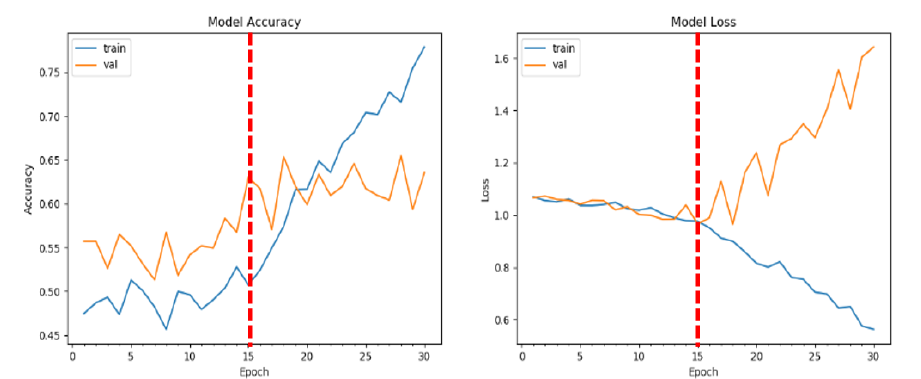
Figure 9. Accuracy and loss values of training and validation using 48 × 48 sized images (Setup II in Table